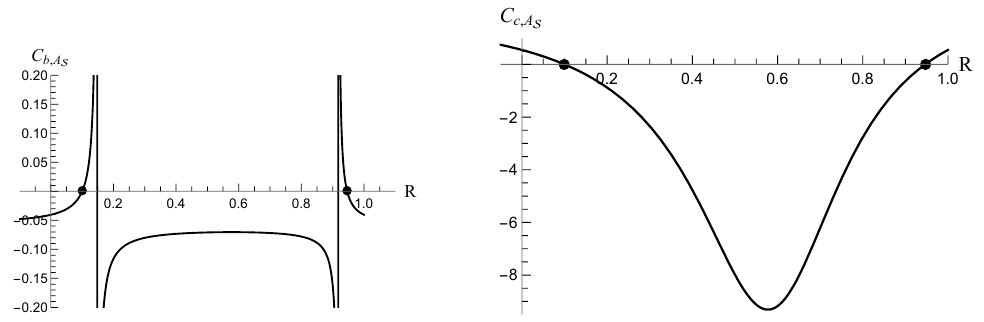
Figure 4 . Heat capacity of black hole system (left) and cosmological system (right) as a function of the boundary radius R for d = 4 . The graphs are meaningful only between the horizon radii (thick circles), where both heat capacities vanish. The minimum on the right lies at the Nariai √ radius L/ 3 . Here r b = 0 . 1 and L = 1